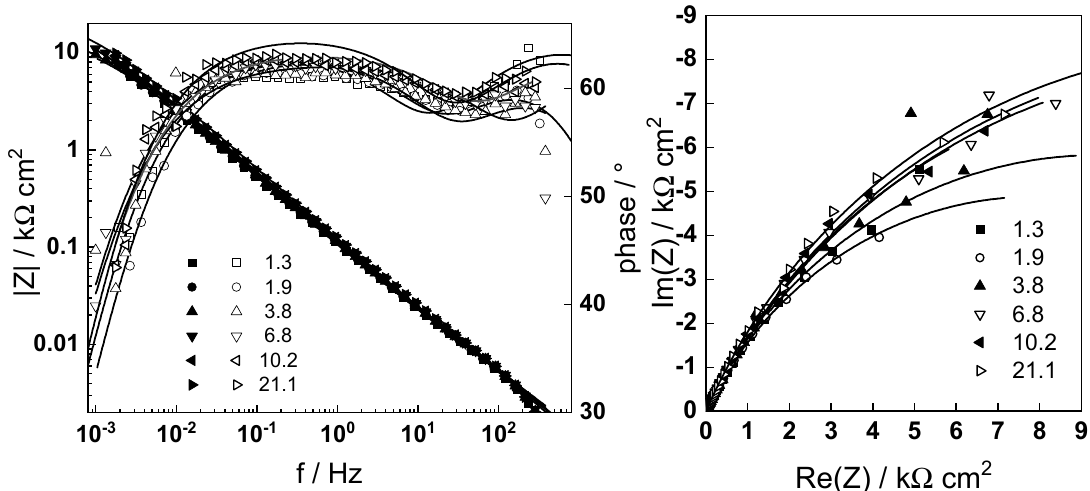
Figure 7. Electrochemical impedance spectra of AISI 316L at 180 ◦ C in AMETA with 1.0 g dm − 3 magnetite particles. ( left )—impedance magnitude (full symbols) and phase shift (open symbols) vs. frequency, ( right )—complex plane representation. Points—experimental data, solid lines—best-fit calculation with respect to the MCM equations discussed in the text. The legend is oxidation time (h).